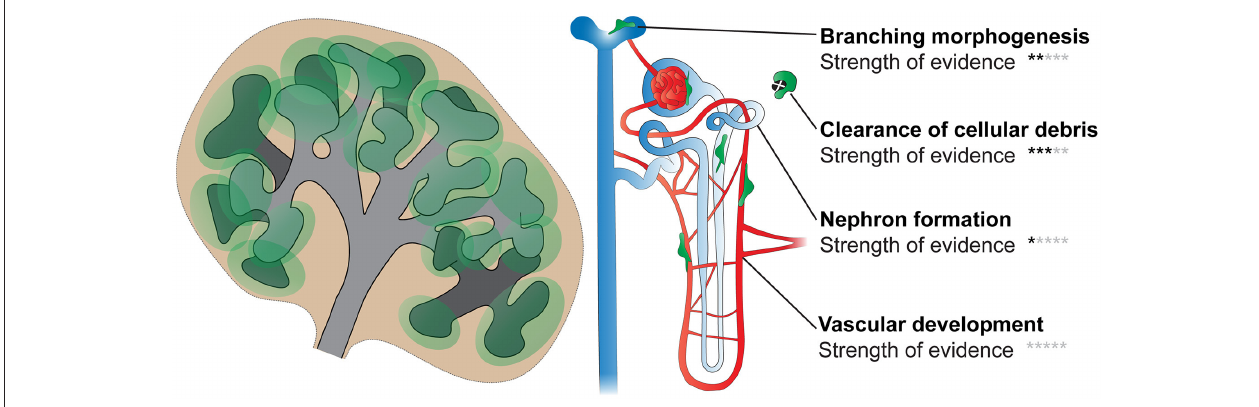
FIGURE 5 | Functions of macrophages in kidney development. Processes including branching morphogenesis, cell proliferation/death (and clearance of cellular debris), nephron formation, and vascular development (blood and lymphatic) are important in renal development. Few studies have directly investigated the roles of kidney macrophages in these processes; however, based on available evidence, it is likely that macrophages will facilitate most, if not all, of these processes. Black stars indicate the strength of evidence that macrophages function in each process in kidney development (0 stars, no direct evidence; 5 stars, very strong